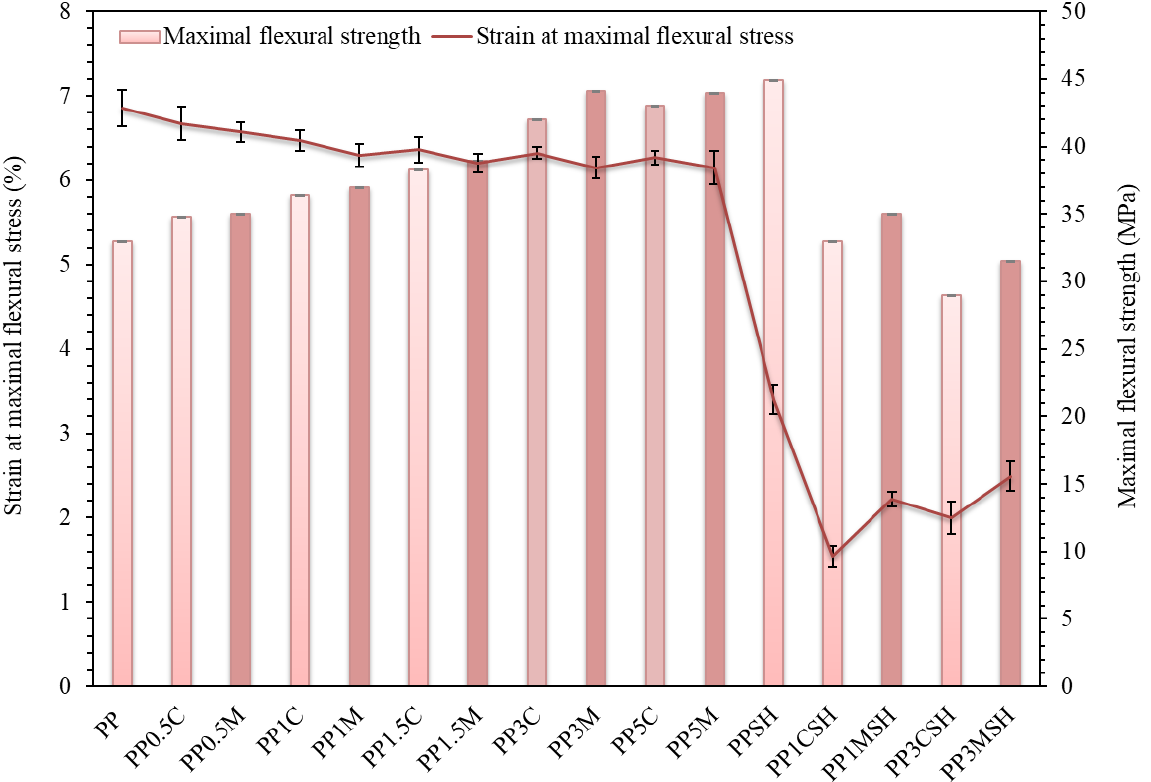
Figure 7. Strain at maximal flexural stress and maximal flexural strength of PP composites and neat PP; darker bars are related to the masterbatch-containing systems. PP; darker bars are related to the masterbatch-containing